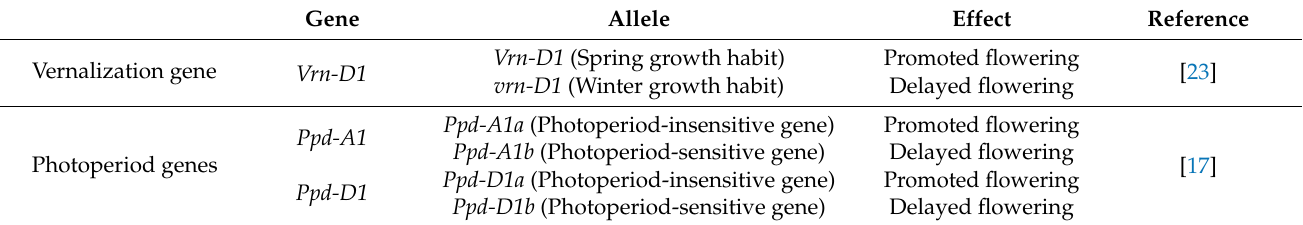
Table 5. Regulatory effects of photoperiod and vernalization alleles on